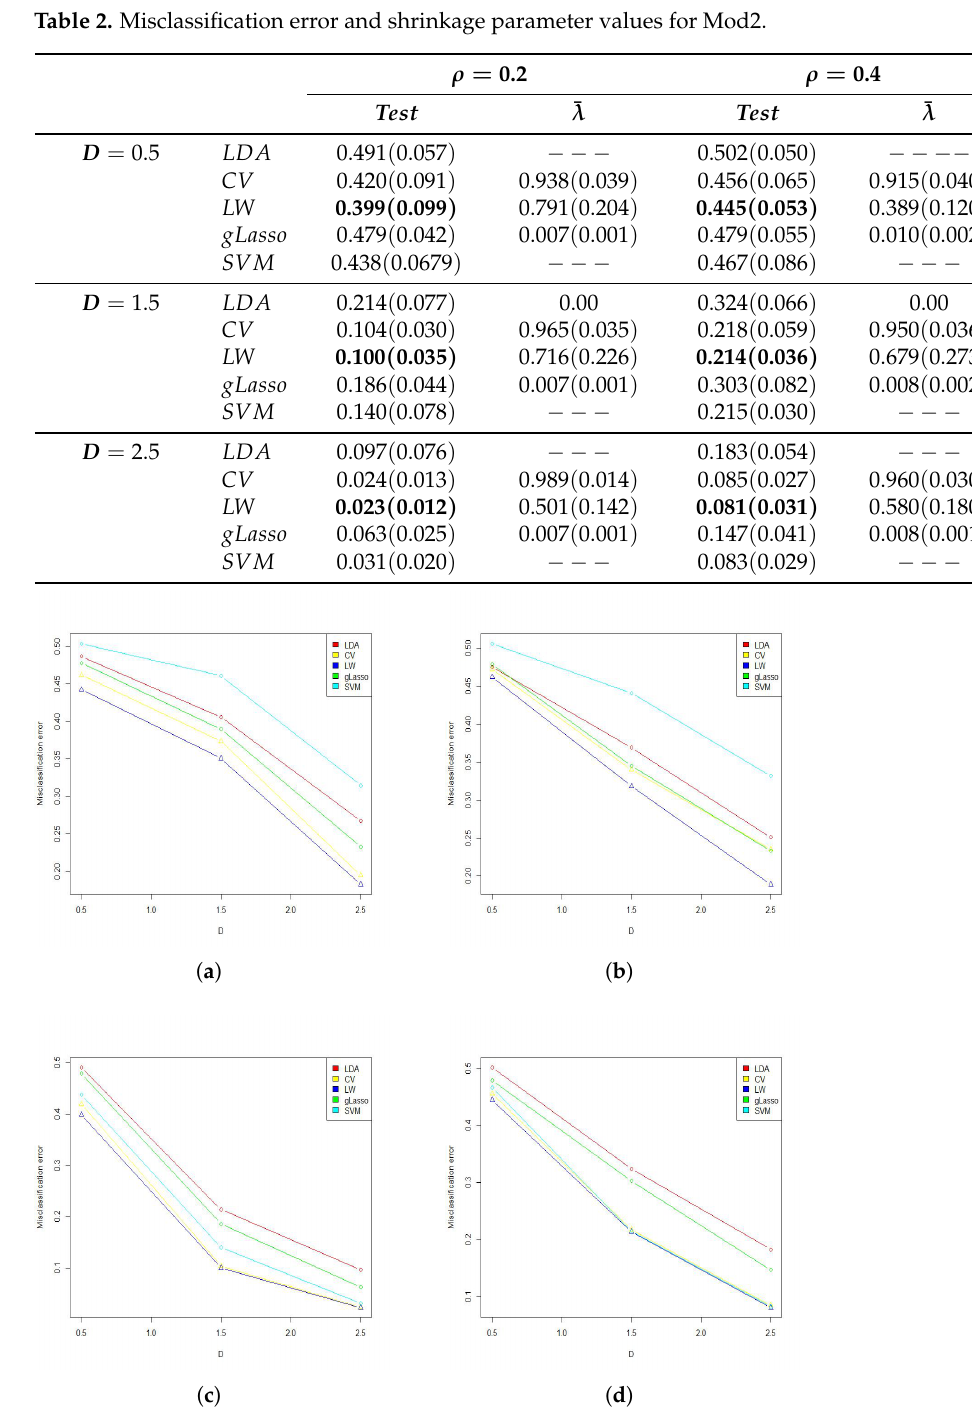
Figure 1. Misclassification error by increasing the Mahalanobis distance. ( a ) Mod1, ρ = 0.2, n = 10; ( b ) Mod1, ρ = 0.4, n = 10; ( c ) Mod2, ρ = 0.2, n = 10; ( d ) Mod2, ρ = 0.4, n =